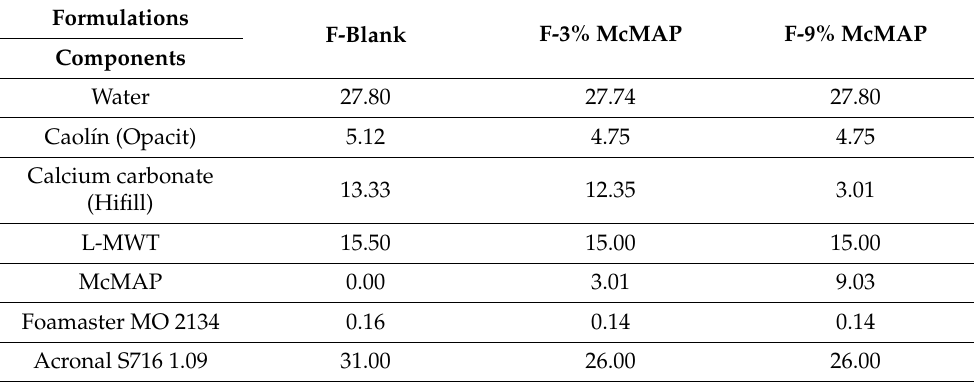
Table 1. Specifications of the experimental materials in the blank formulations F3, and F9. All formu- lations were prepared in ( w / w )—3 and 9 indicate the percentage of microcapsules of monoammonium phosphate (McMAPs)